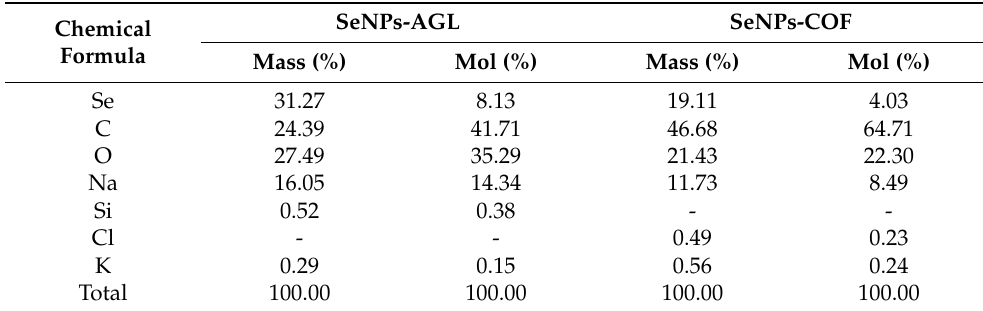
Table 3. Elemental composition via Litesizer of the selenium nanoparticles (SeNPs) synthesized with extracts of A. glaucum (SeNPs-AGL) and C. officinalis (SeNPs-COF).